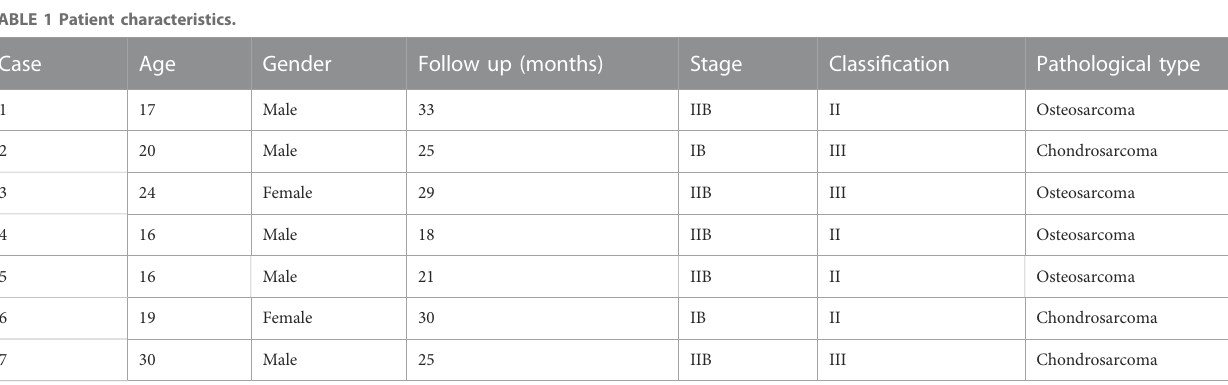
TABLE 1 Patient